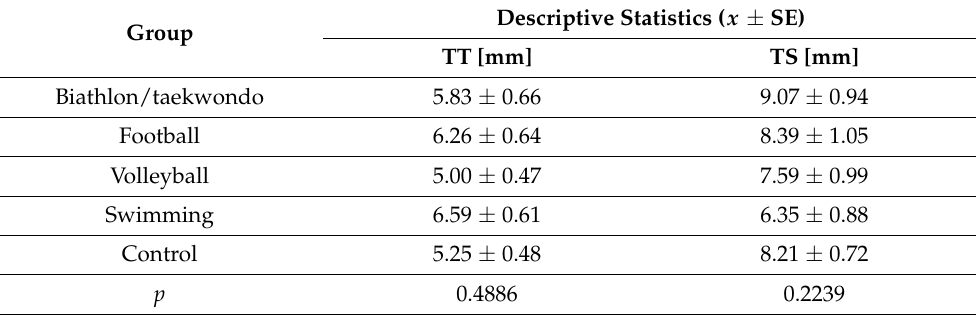
Table 5. Characteristics of the TT and TS